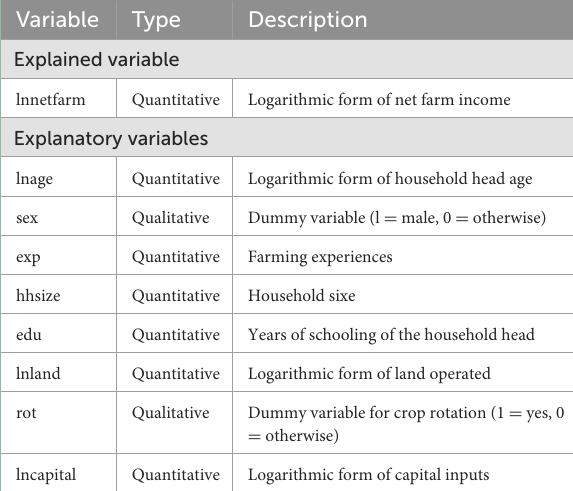
TABLE 1 Summary of model